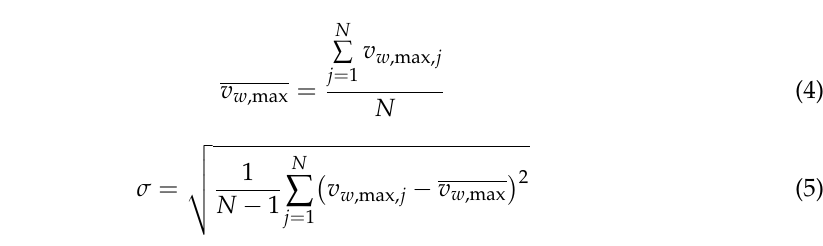
Figure 12. Comparison of vibration of the over-track building and the US standard.